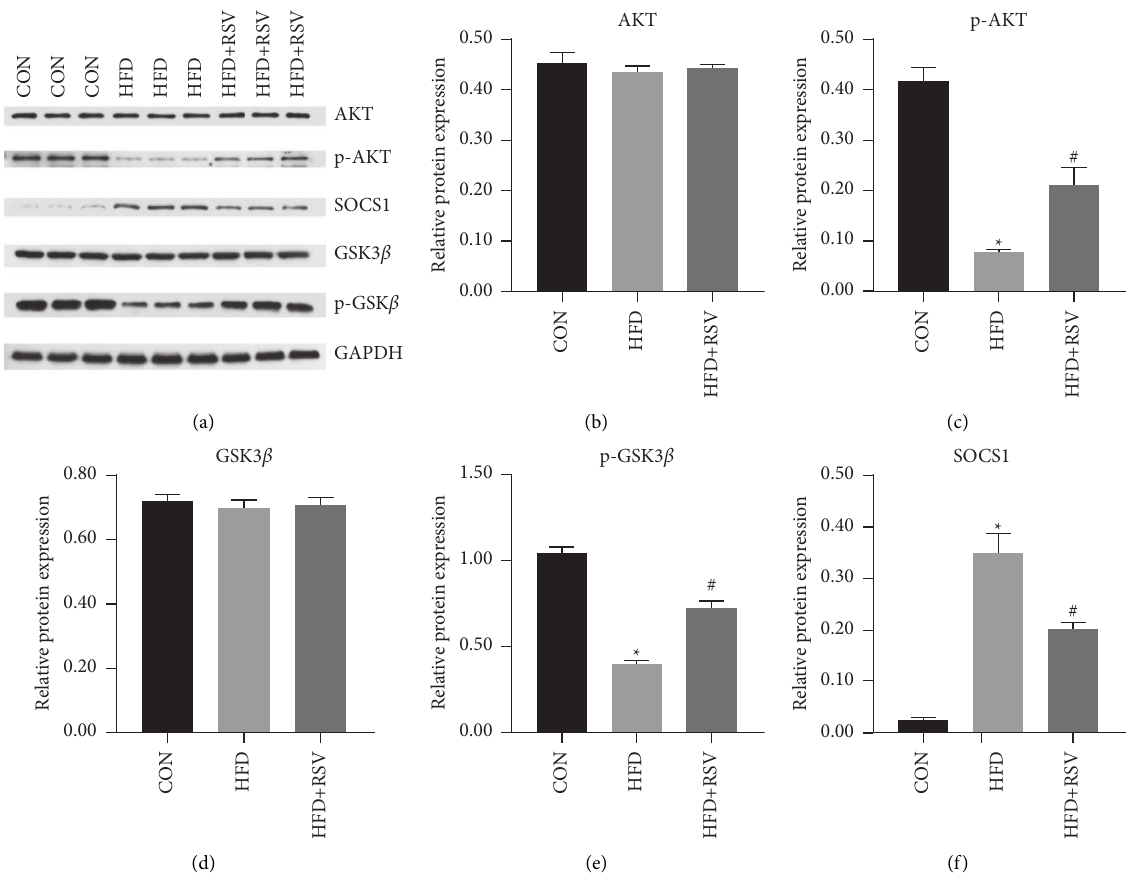
Figure 1: Effects of resveratrol on the insulin signaling pathway in control, HFD, and HFD +RSV groups. (a) Bands of western blot; (b) AKT; (c) p-AKT; (d) GSK3 β ; (e) p-GSK3 β ; (f) SOCS1. Data are expressed as the mean ± SD ( n � 6). ∗ P < 0 . 05 versus CON; # P < 0 . 05 versus